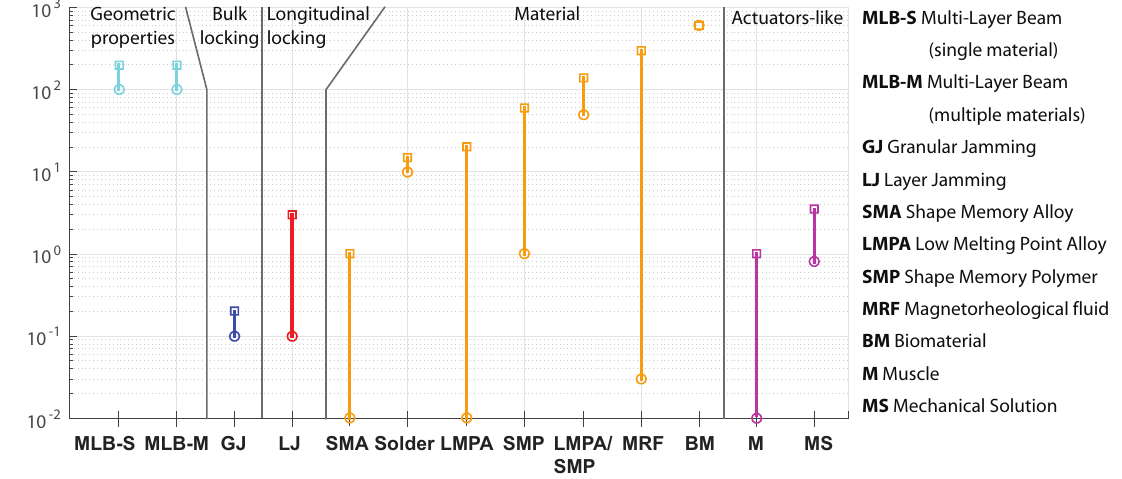
Figure 9. Activation time for several controllable stiffness solutions. The activation time corresponds to the change between the rigid and the flexible states, and inversely. A fast change of stiffness is preferred. The values correspond to averages and depend on the design of the solutions. The biomaterial value corresponds to the skin of